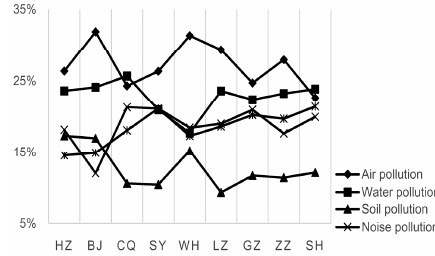
Figure 1. Residents’ attention to environmental problems in different cities. Table 3. Residents’ perception on soil contamination.